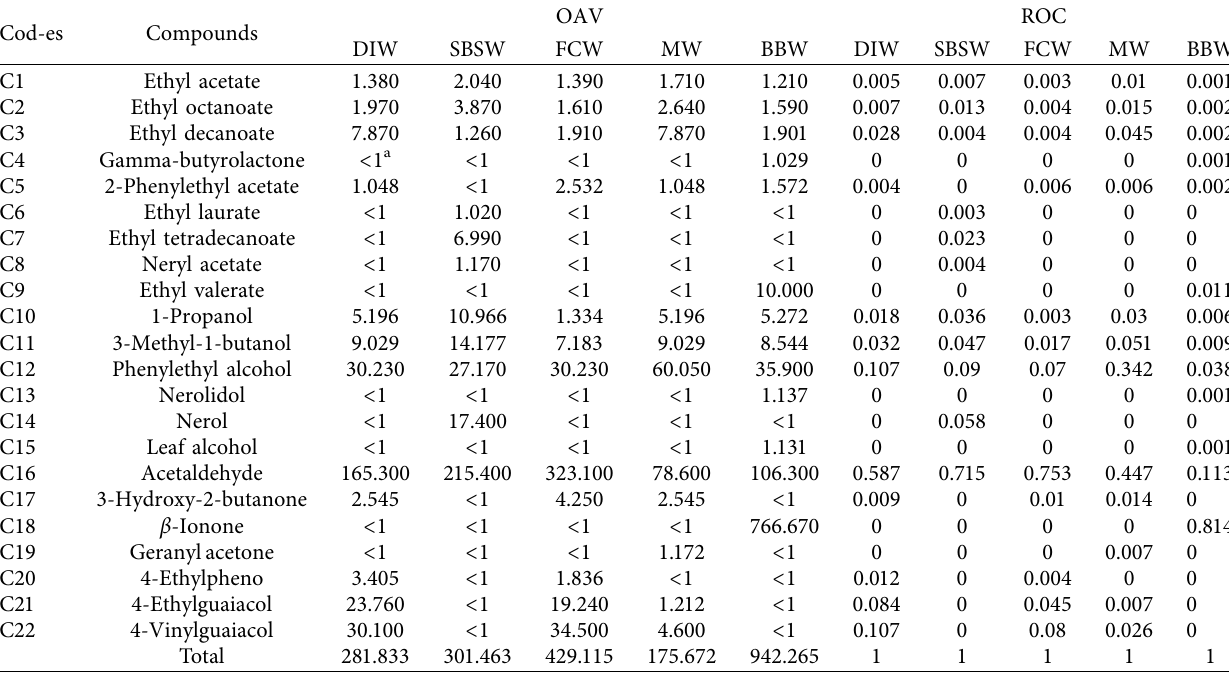
Table 4: OAV and ROC contents of volatile compounds in five home-brewed wines.